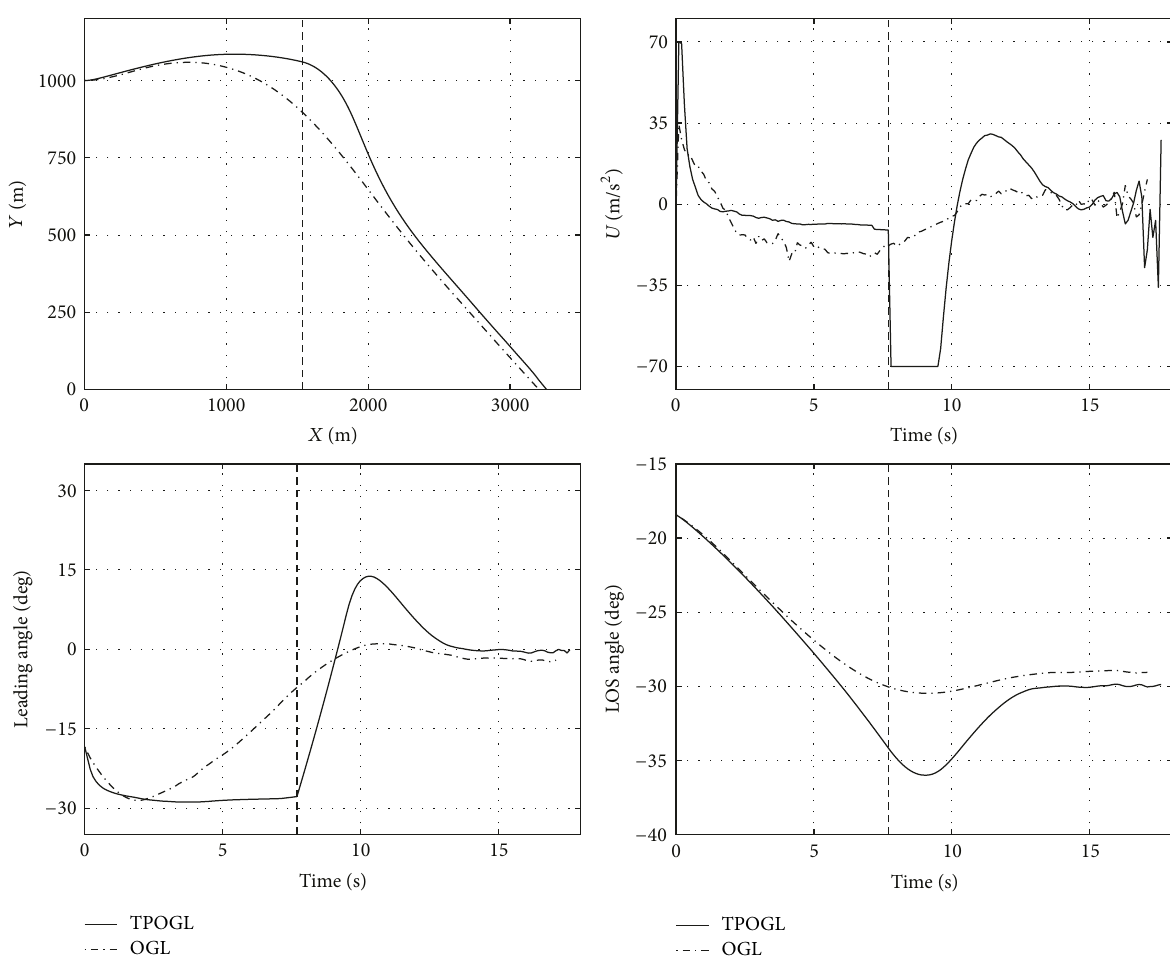
Figure 9: Simulation results comparisons against maneuvering